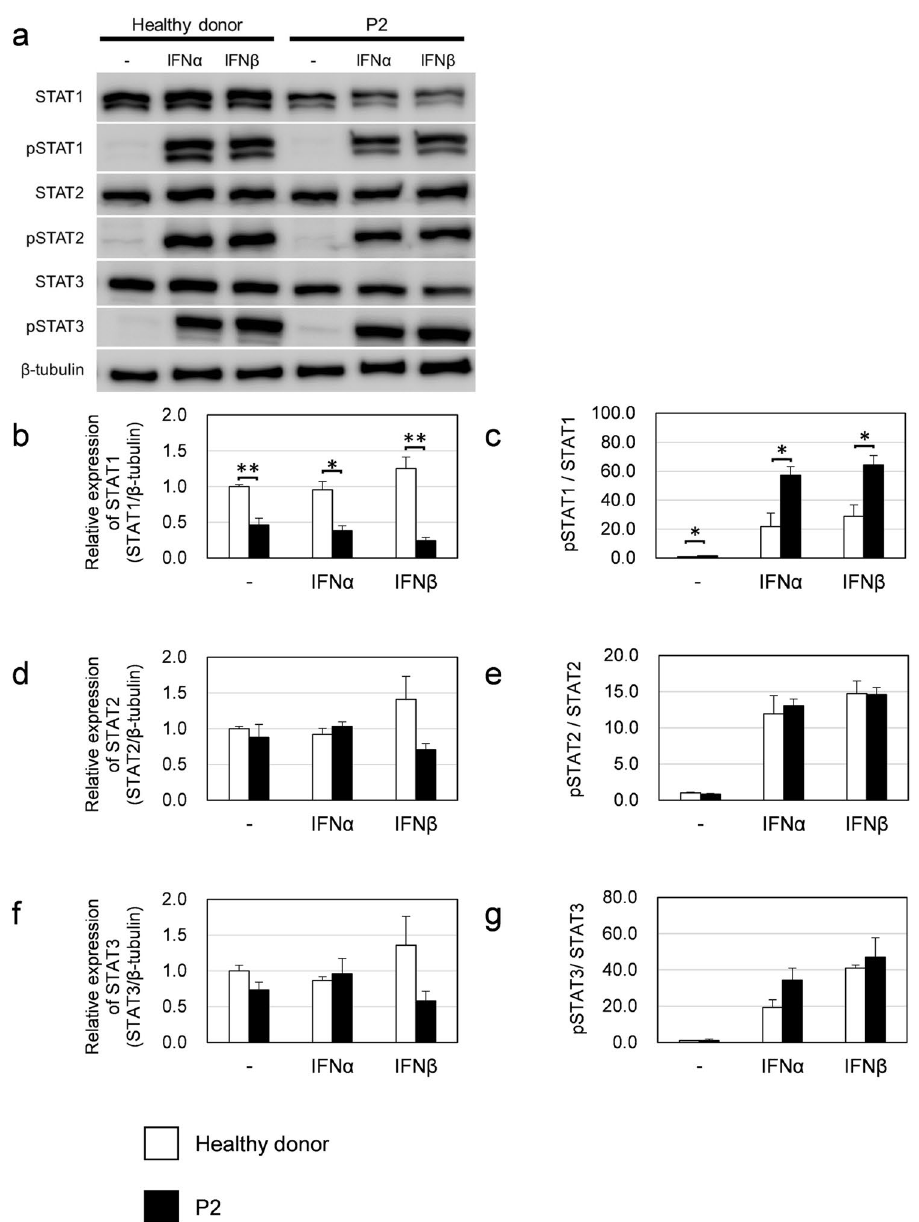
Figure 3. Type I IFN-induced STAT activation in EBV-BCLs from a healthy donor and the patient. ( a ) Total STAT and tyrosine-phosphorylated STAT (pSTAT) protein levels were analyzed by western blotting. Cells were stimulated with IFN- α (1000 U/mL) or IFN-ß (500 U/mL) for 15 min. ( b – g ) Based on three independent analyses, the expression levels of STAT proteins ( b,d,f ) and pSTAT proteins ( c,e,g ) in the patient-derived EBV- BCLs were compared with those in untreated healthy donor-derived cells (n = 3 EBV-BCLs per genotype). Data represent mean ± SEM. ** P < 0.01, * P < 0.05. P values were derived from 2-tailed Student’s t-test. Full-length immunoblots are presented in Supplementary Fig.